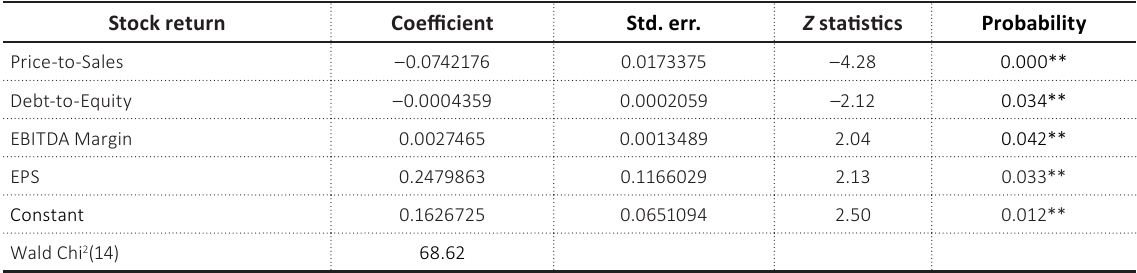
Table 15. Regression results computed using two-way mixed effects model Stock